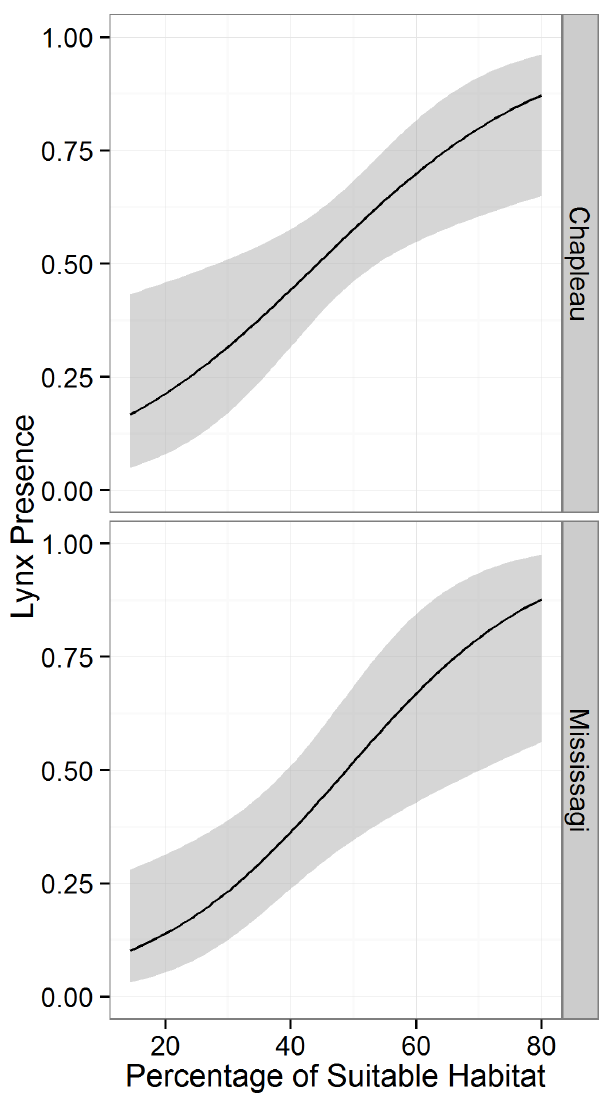
Figure 4. Regression plots for logistic models of Canada lynx occurrence in relation to the proportion of suitable habitat at the 25 km 2 spatial scale in the Mississagi and Chapleau regions with moderate levels of fragmentation. The shaded area indicates the standard error.